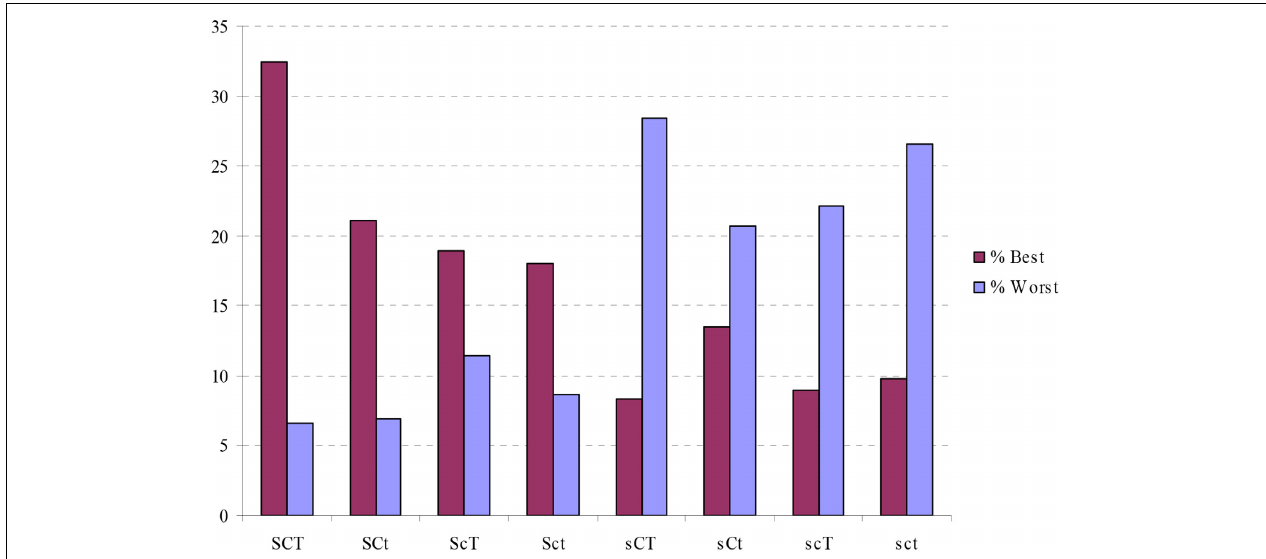
FIGURE 5 | Percentage of people in each character profile who have “best health” or “worst ill-health.” SCT, creative; SCt, Organized; ScT, Fanatical; Sct, Autocratic; sCT, Moody; sCt, Dependent; scT, Disorganized; sct,